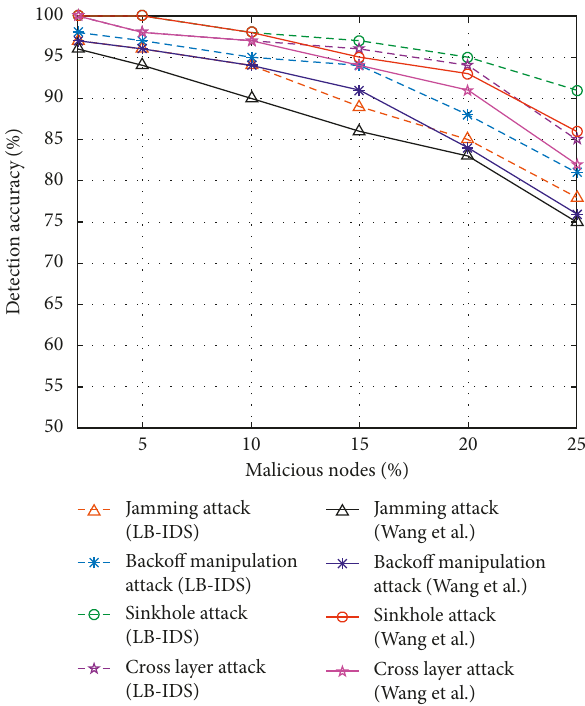
Figure 10: DA comparison between LB-IDS and Wang et al. scheme [1].